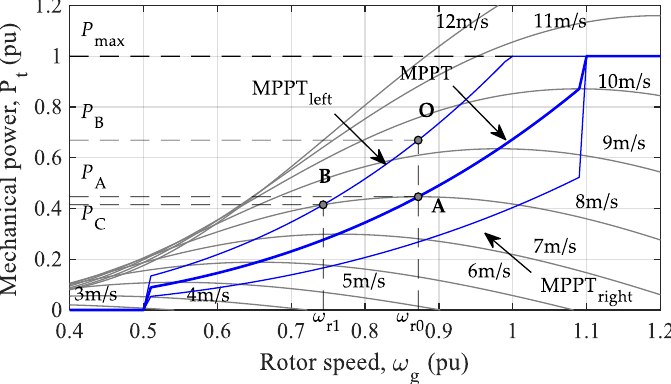
Figure 7. Maximum power point tracking (MPPT)-curve shifting